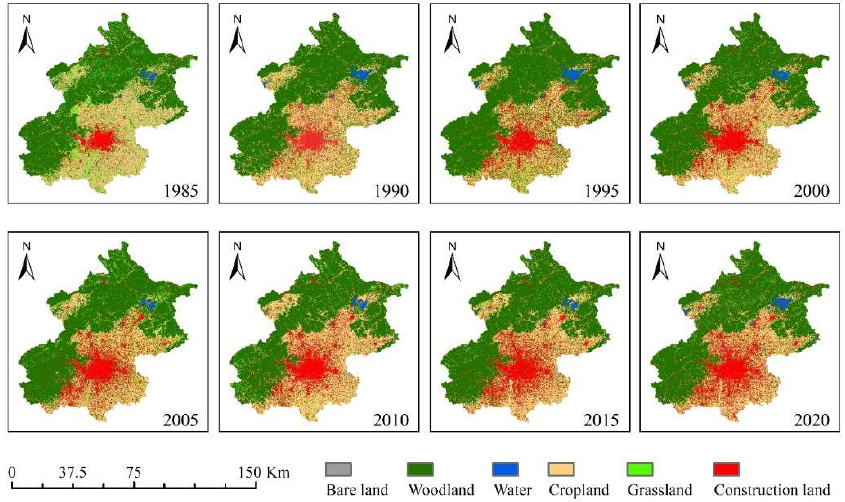
Table 3. The land use pattern changes from 1985 to 2020 in Beijing (km 2 ).